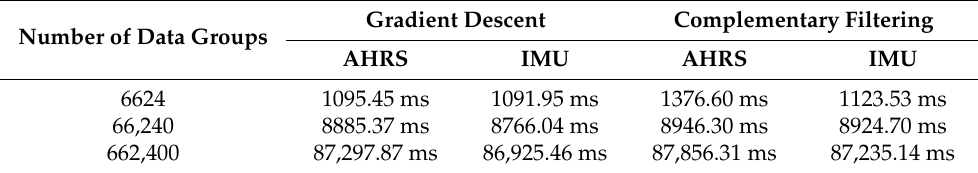
Table 3. Time consumption of processing data with different filters.